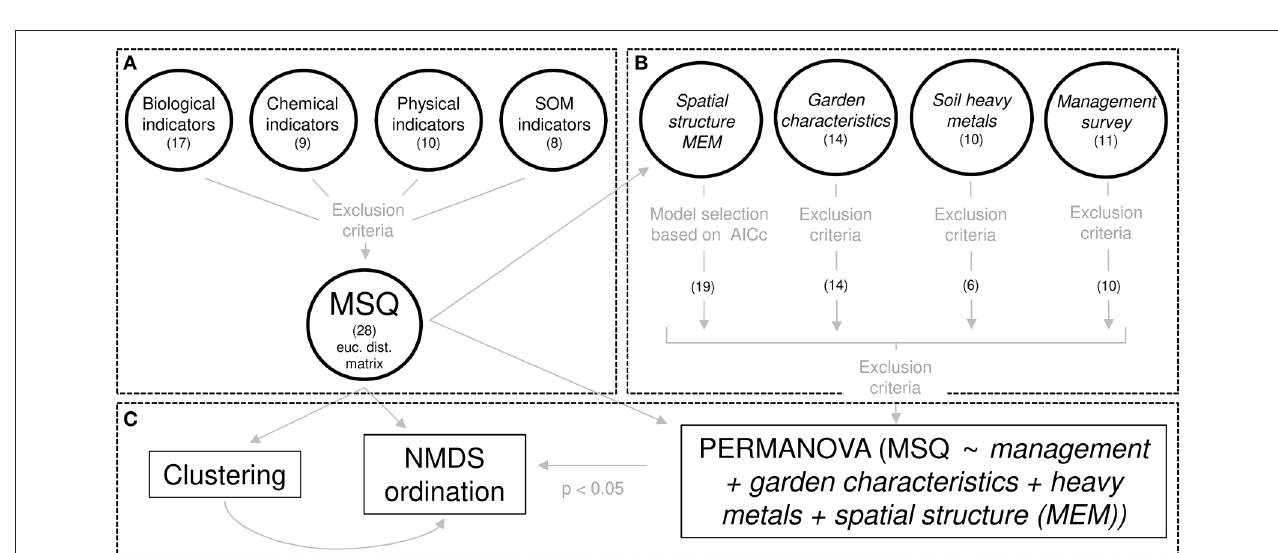
FIGURE 2 | Scheme for the multivariate soil quality assessment. (A) There are in total 44 measures of soil quality (MSQ). Exclusion criteria ( r < 0.6 and or a variance inflation factor >4 (Borcard et al., 2011)) reduced MSQ by 16 variables. (B) Explanatory variables are written in italics. Moran eigenvector maps (MEM) were selected based on smallest AICc (cf. section 2.4.3). (C) MSQ as response matrix with Euclidean distances and explanatory variables (Figure S11) were used in a PERMANOVA. Thereafter, significant explanatory variables ( p <0.05) were fitted on the NMDS ordination of MSQ. A fuzzy clustering of the MSQ was obtained and the three groups were plotted on the NMDS plot ( Figure 3